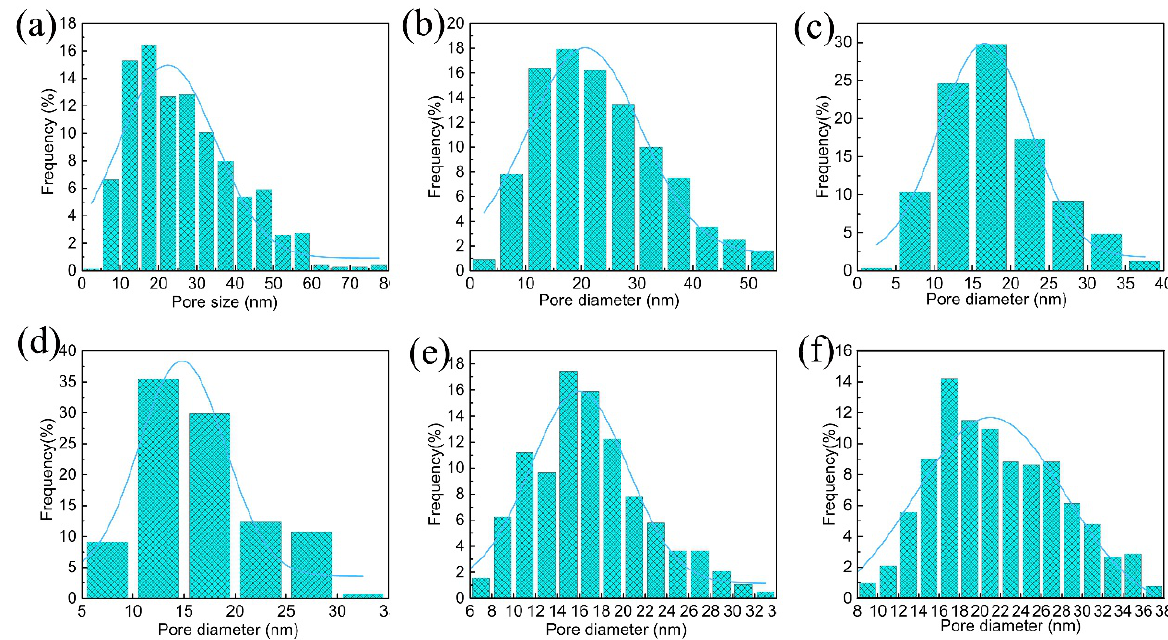
Figure 2. Pore size distribution of different supports: ( a ) support-0, ( b ) support-1, ( c ) support-2, ( d ) support-3, ( e ) support-4, ( f ) support-5.